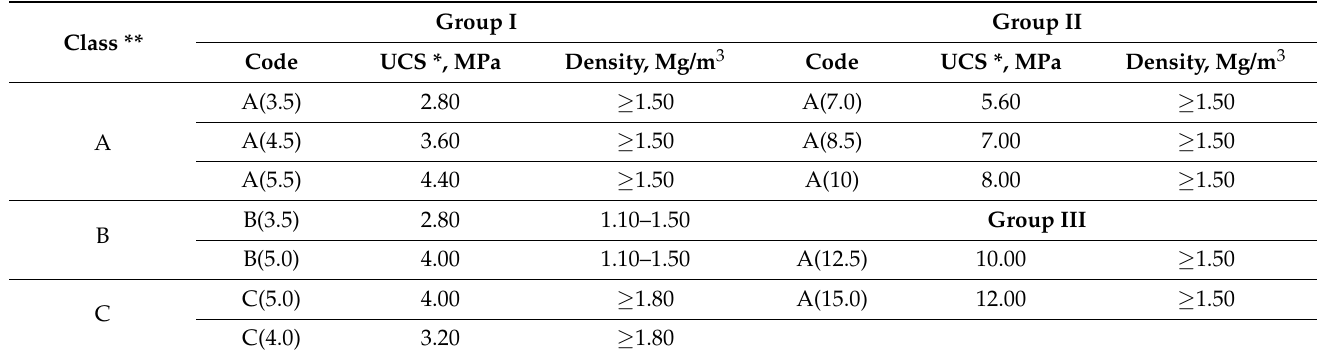
Table 12. Specification of masonry concrete blocks as per Indian standard